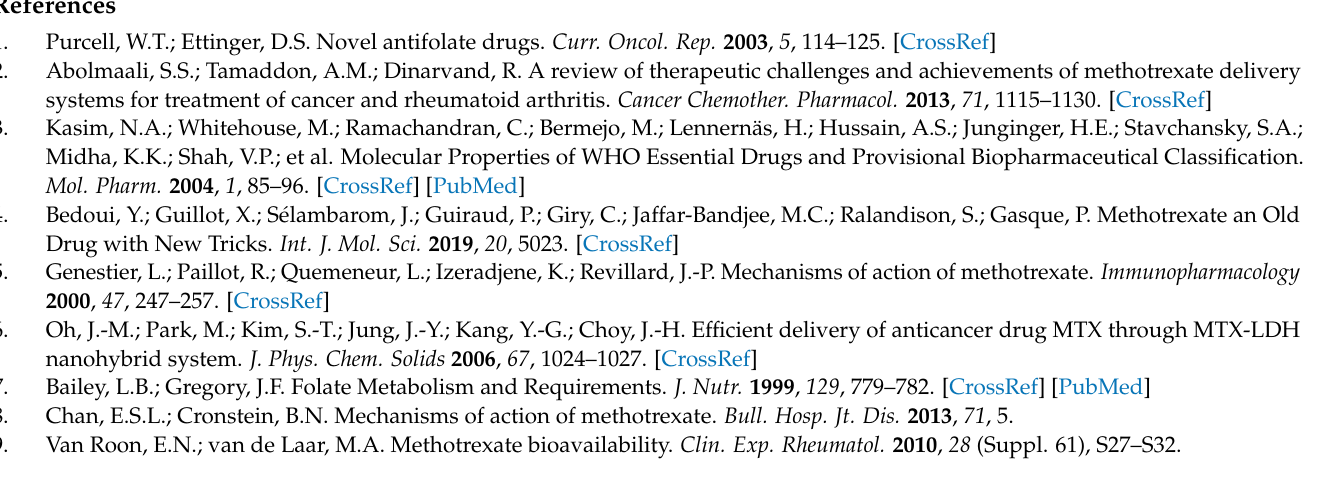
± S.D. ( n = 3), Figure S5: Mathematical models showing the fitting of PEG-MTX-LIP. Results are representative of three independent experiments ± S.D. ( n = 3), Figure S6: Mathematical models showing the fitting of Combo-LIP. Results are representative of three independent experiments ± S.D. ( n = 3), Figure S7: Physicochemical characterization of Cy5-LIP (A) and DSPE-CY5 release profile (B), Figure S8: Image reporting a maximum intensity profile of a z-stack of BMDMs treated with liposome reporting in blue the nuclei, in green the plasma membrane and in red the liposomes, split channel